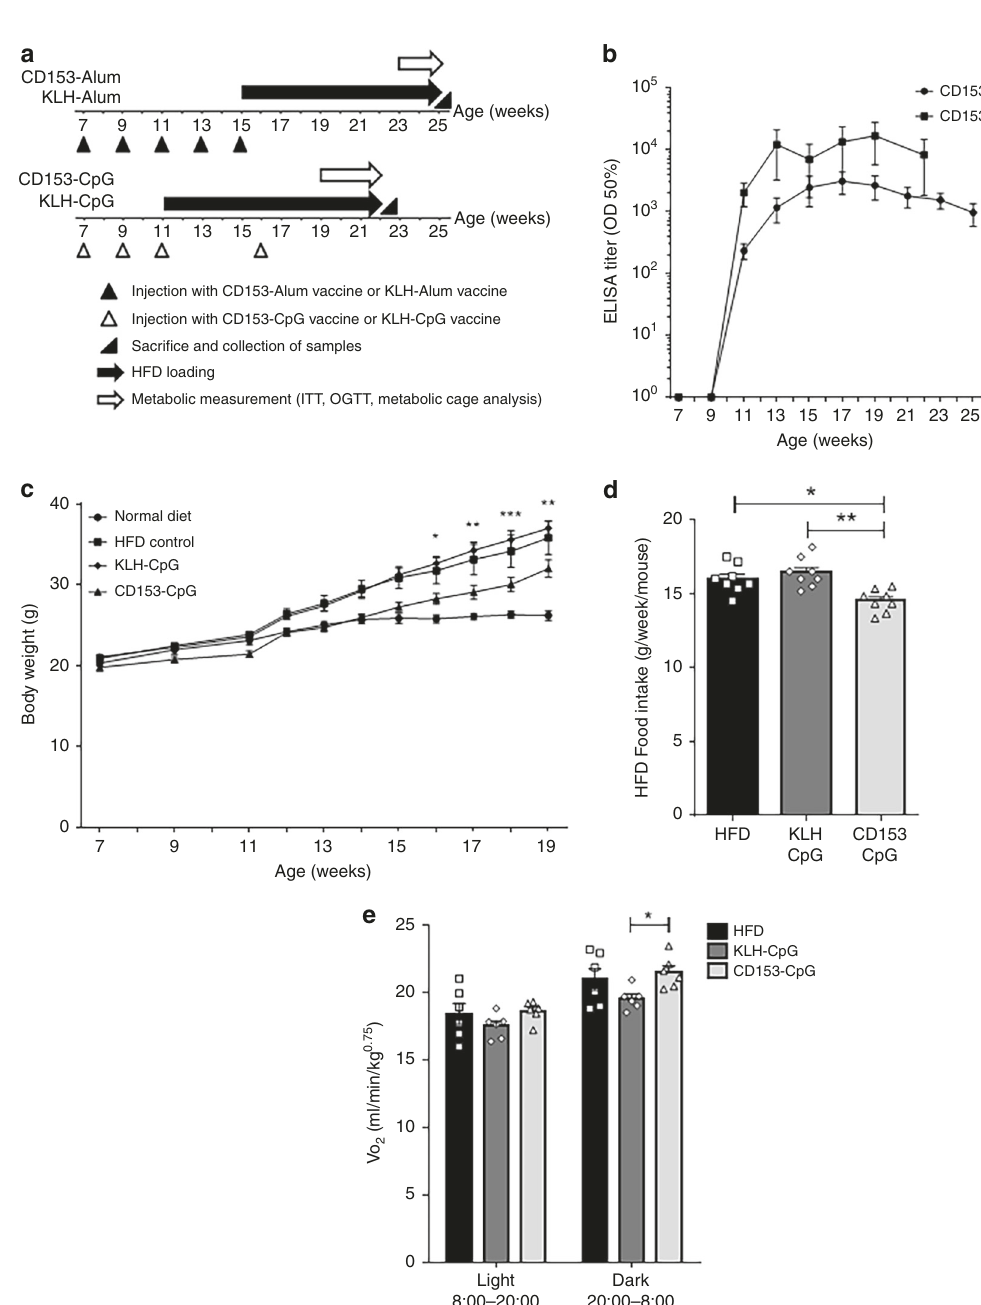
Fig. 2 Metabolic analysis of HFD-loaded mice immunized with the CD153 vaccine. a Time course of HFD loading and injection of vaccines. Mice immunized with the CD153-Alum vaccine or the KLH-Alum vaccine ( n = 3 in each group) were vaccinated at the ages of 7, 9, 11, 13, and 15 weeks and fed a HFD from the age of 15 weeks. Mice immunized with the CD153-CpG vaccine or the KLH-CpG vaccine ( n = 6 in each group) were vaccinated at the ages of 7, 9, 11, and 16 weeks and fed a HFD from the age of 11 weeks. Mice in the ND (normal diet) control group ( n = 5) were unvaccinated and fed a ND, while mice in the HFD control group ( n = 6) were unvaccinated and fed a HFD from the age of 11 weeks. b Titers against CD153-BSA in mice immunized with the CD153-Alum vaccine ( n = 3) or the CD153-CpG vaccine ( n = 6) during HFD loading. Titers are expressed as the half-maximal binding (OD 50%). c The body weights of mice in the ND control group ( n = 5), mice in the HFD control group ( n = 6), and mice immunized with the CD153-CpG vaccine ( n = 6) or the KLH-CpG vaccine ( n = 6) before metabolic measurement. Asterisk indicates the CD153-CpG group vs. the KLH-CpG group. d The weekly average amount of HFD intake per mouse (g/week/mouse) in mice immunized with the CD153-CpG vaccine or the KLH-CpG vaccine during HFD loading. Data were collected from 11 to 19 weeks of age ( n = 8 in each group). e The average VO 2 values during the light (8:00 – 20:00) and dark (20:00 – 8:00) periods in mice in the HFD control group ( n = 6) and in mice immunized with the CD153-CpG vaccine ( n = 6) or the KLH-CpG vaccine ( n = 6) at the age of 21 – 22 weeks. All the data are expressed as the mean ± SEM. Statistical evaluation was performed by two sided; Tukey ’ s multiple comparison test ( c , d ); Bonferroni correction, HFD vs. KLH-CpG vs. CD153-CpG ( e ); * p < 0.05; ** p < 0.01; *** p <